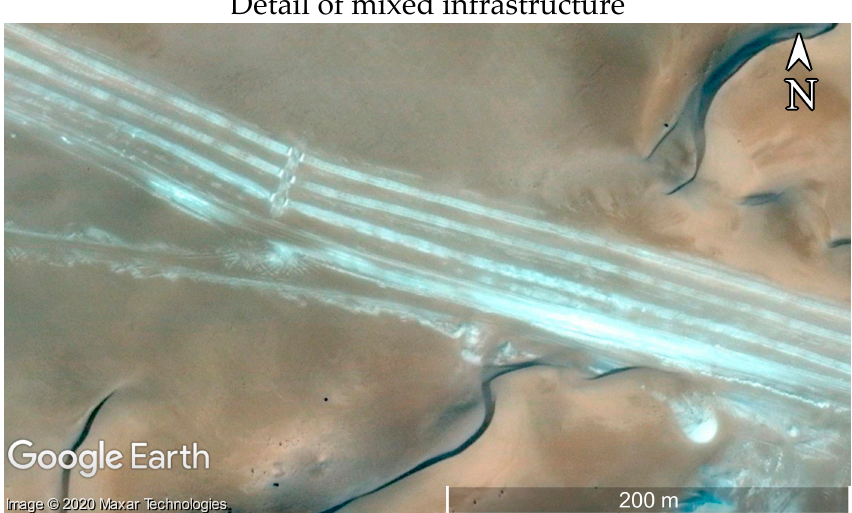
Figure 15. Close–up of a road segment in VHR optical data available on Google Earth Pro. The area corresponds with that shown by the red arrow in Figures 12 – 14. The road segment was not detected by the model. As evident in the figure, the road runs parallel with other infrastructure, which may have a ff ected the ability of the model to correctly interpret the scene. The imagery date is reported to be 13 September